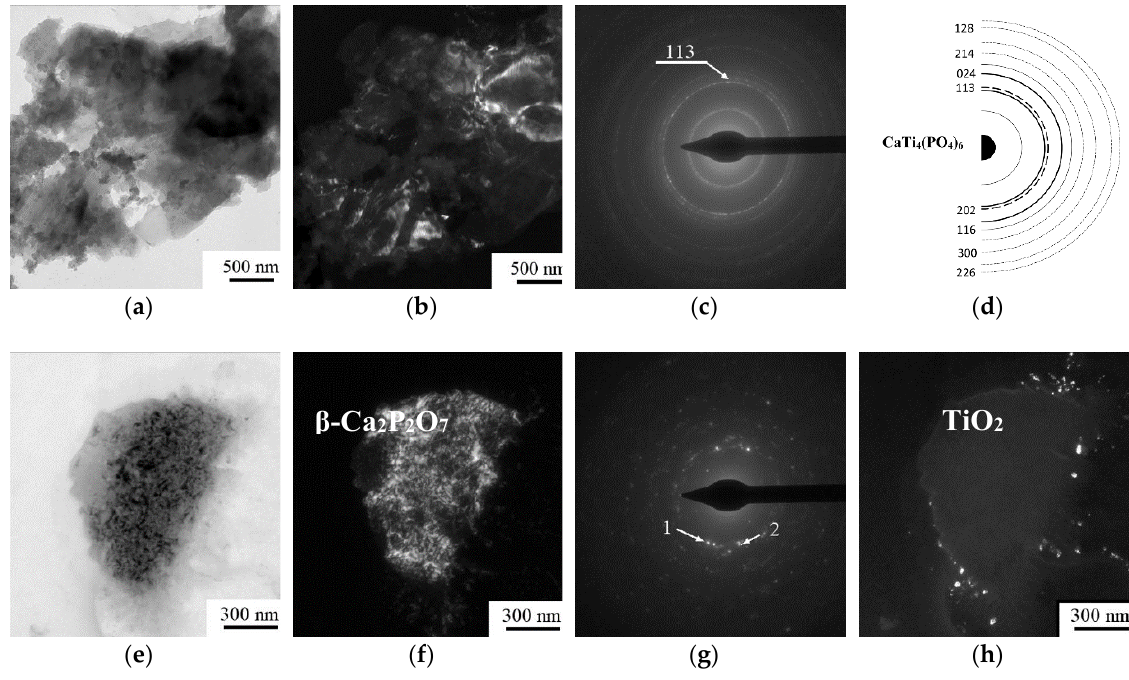
Figure 4. TEM bright field image ( a , e ) and corresponding selected area diffraction ( c , g ), dark field image ( b , f , h ), and scheme showing the interpretation ( d ) of the microarc CP coating on titanium after annealing at 1073 K.